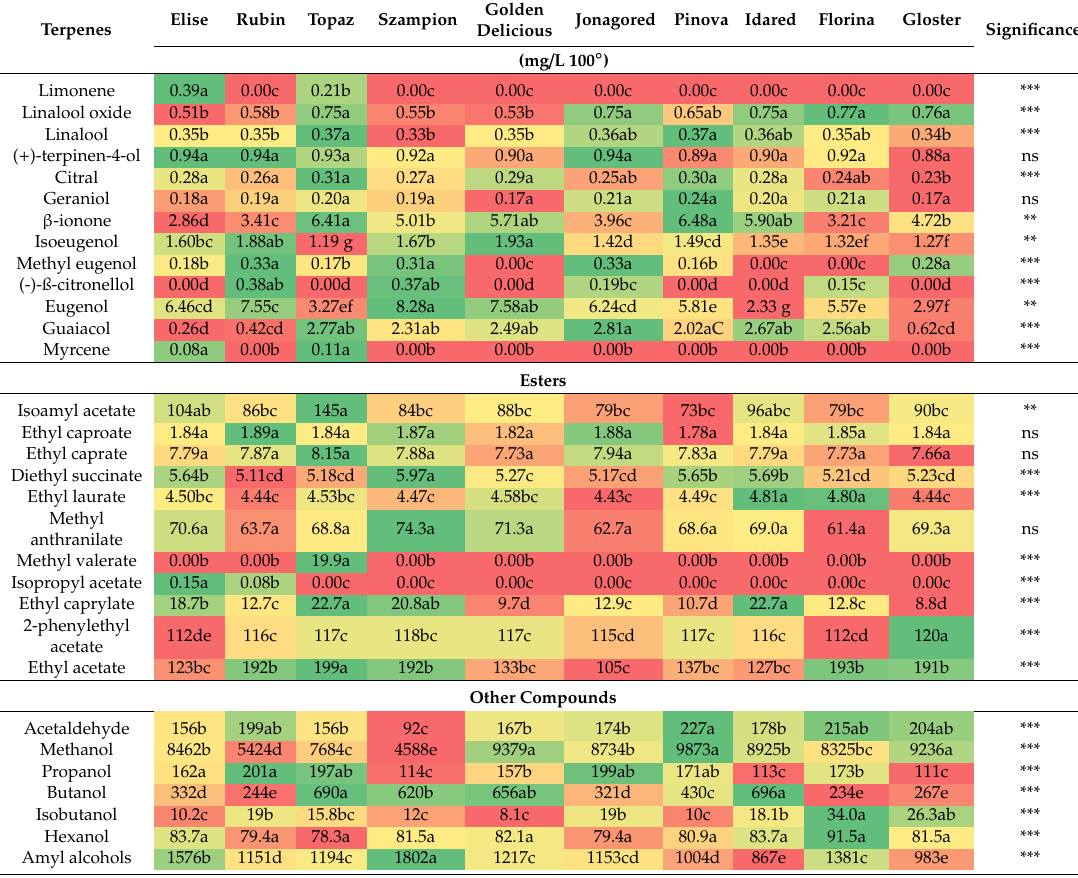
Table 3. Volatile compounds of brandies obtained by distillation of fermented musts from di ff erent apple cultivars by gas chromatography–flame ionization detector (GC-FID).